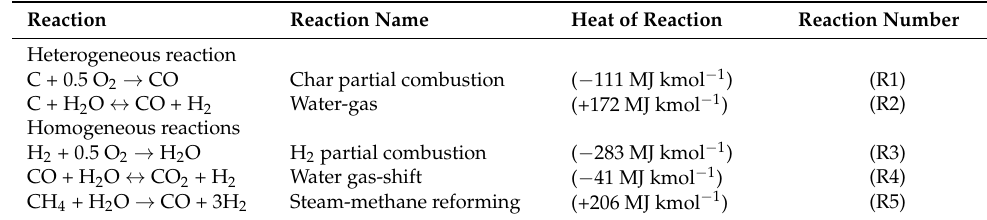
Table 4. Gasification reactions [23].